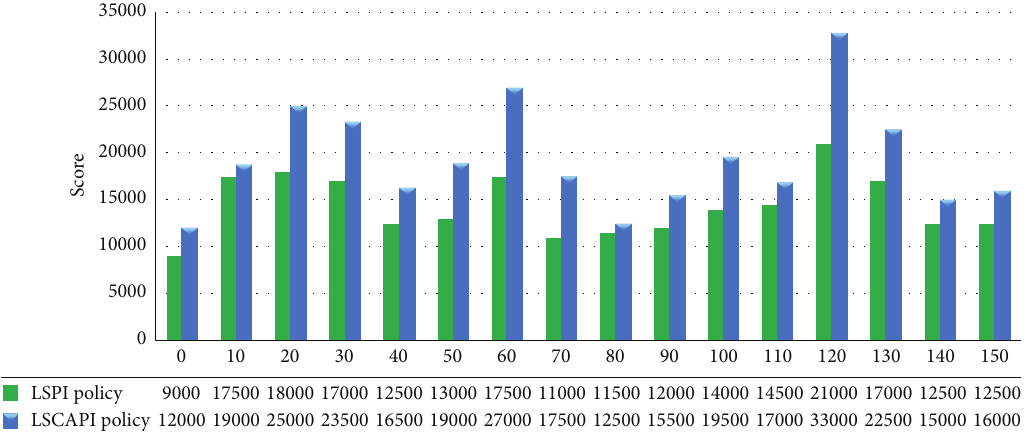
Figure 16: LSPI versus LSCAPI policy score on Duel scenario.